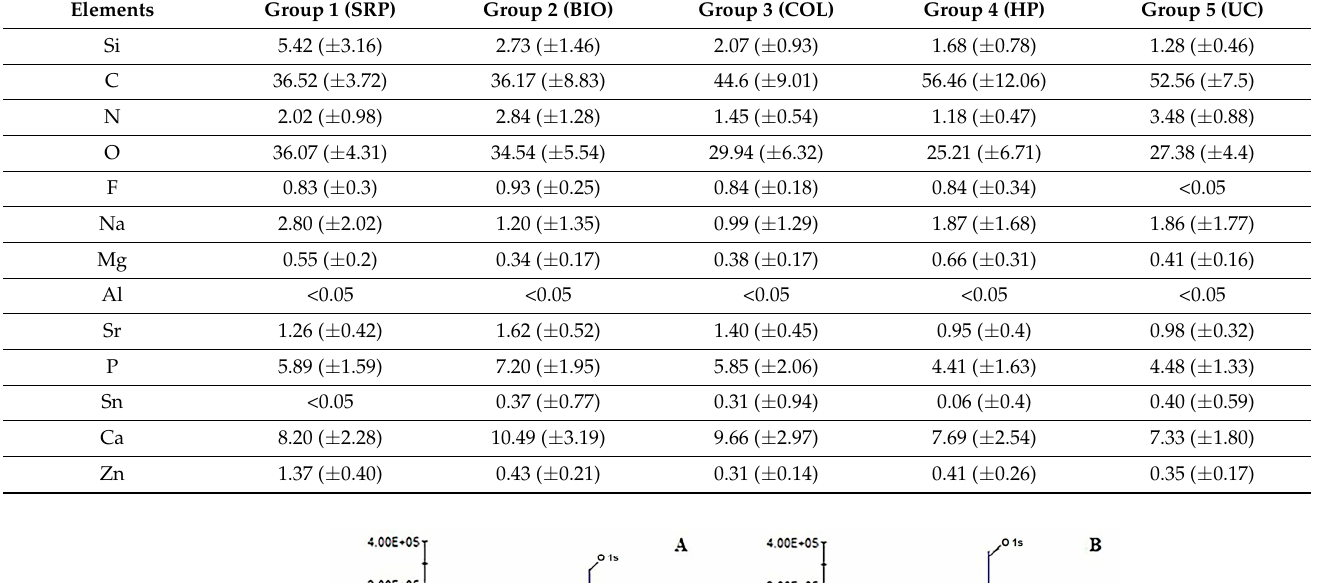
Table 3. Elemental composition (atomic %, Mean ± SD) of enamel samples using the XPS.